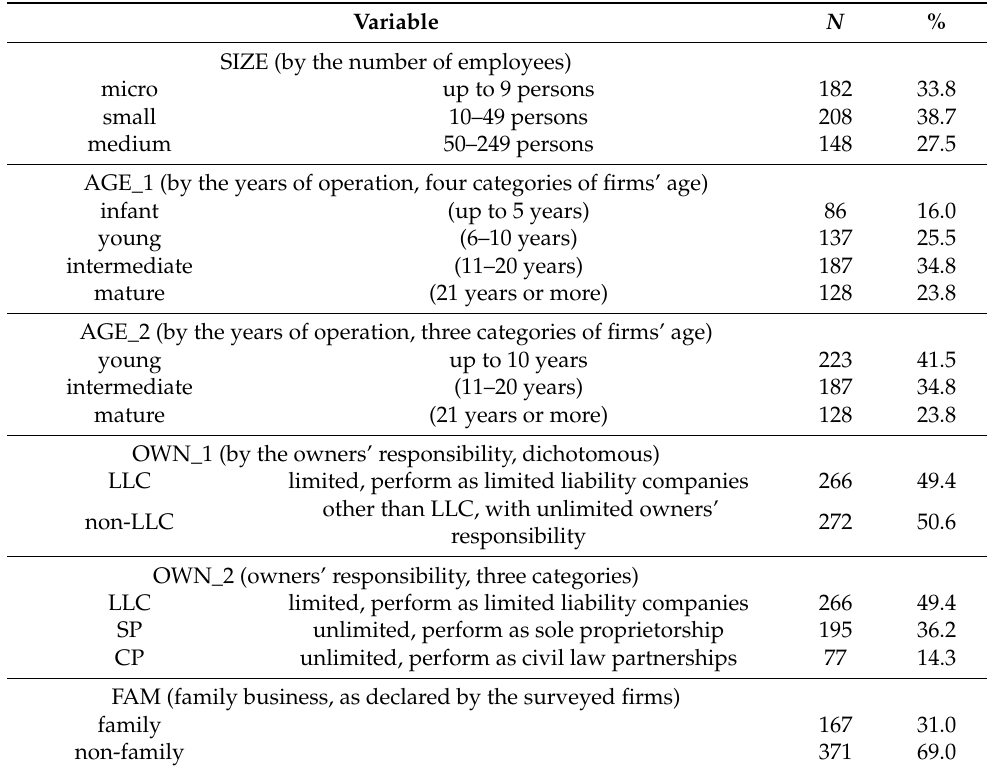
Table 2. Sample composition and variables that explain businesses’ characteristics relevant to this